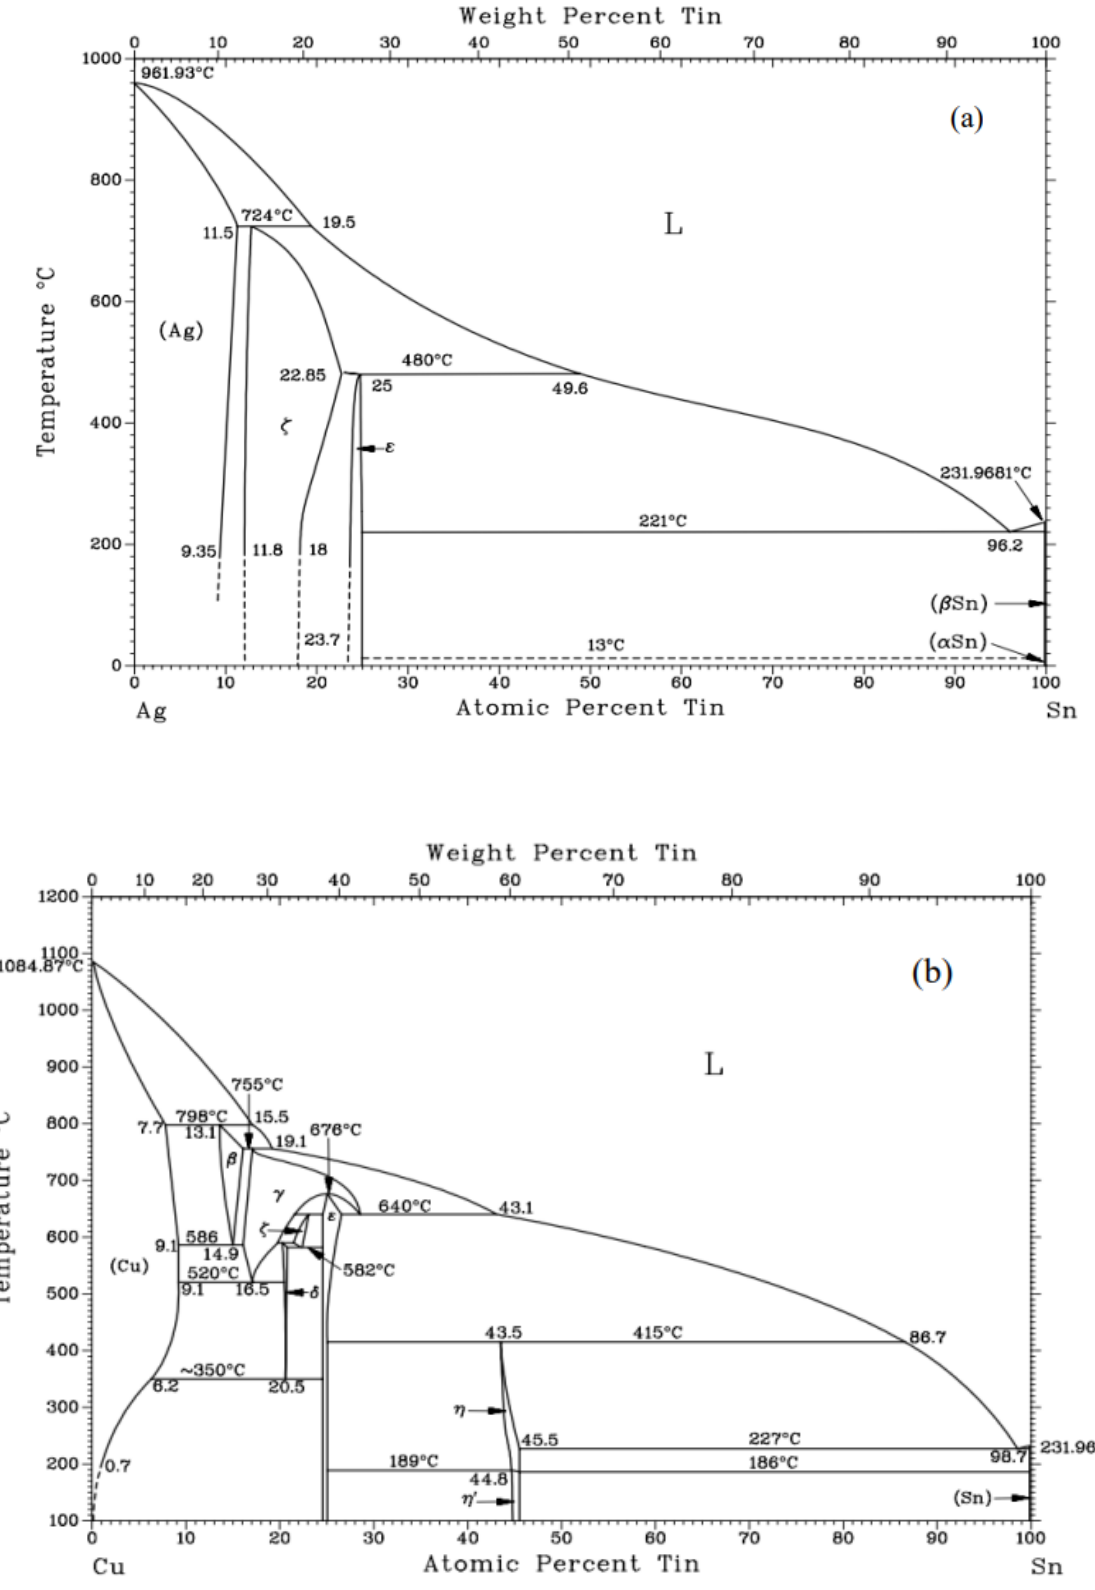
Figure 1. ( a ) Ag-Sn phase diagram; ( b ) Cu-Sn phase diagram [19].